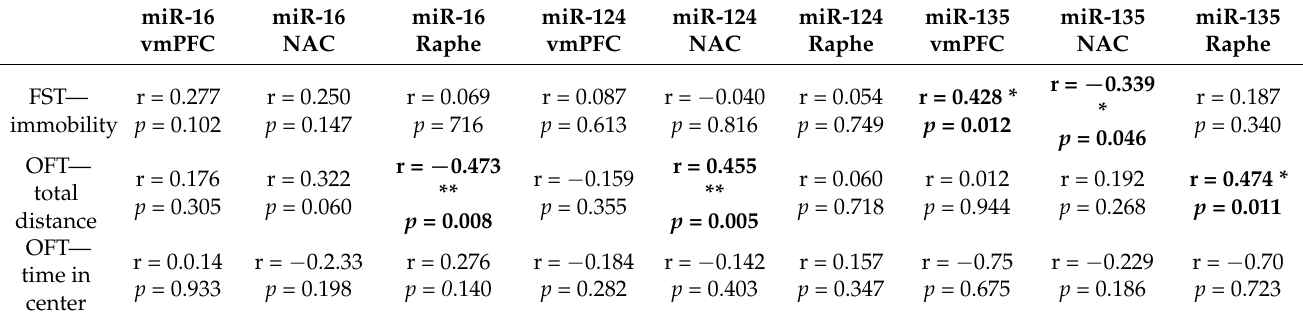
Table 1. Pearson correlation coefficients between miRNA levels and behavioral measures in rats exposed to UCMS and